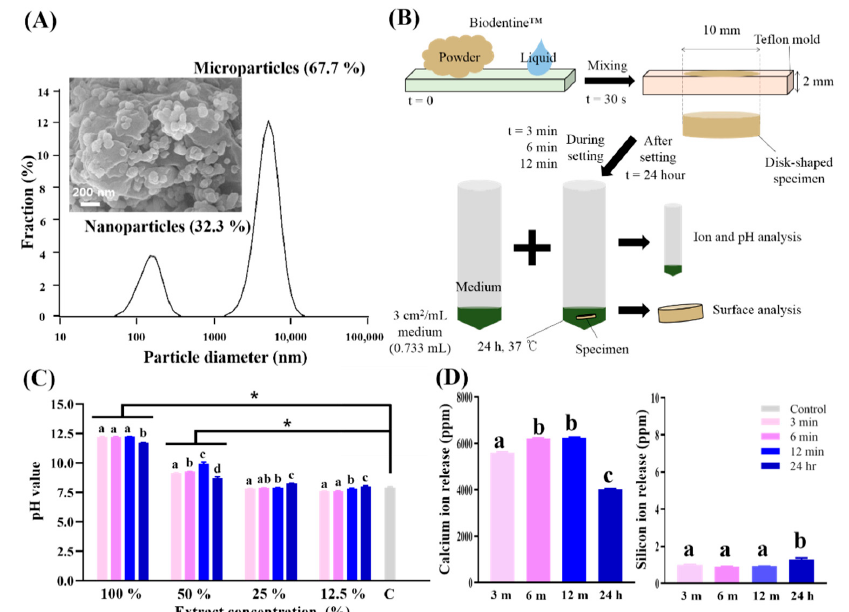
Figure 1. Schematic of this test procedure with di ff erent setting times for specimens and results of physicochemical analysis. ( A ) Particle size analysis of tricalcium silicate nanoparticle-containing cement (Biodentine ™ ) powder confirmed that the powder was composed of nanoparticles and microparticles. Scanning electron micrograph ( × 50,000) of the Biodentine ™ powder exhibited inhomogeneous microstructured surfaces with nanoparticles (approximately 100 nm). ( B ) The methodology used in the present study. To evaluate the biological e ff ect of Biodentine ™ , the specimens were collected after 3, 6 and 12 min and 24 h from starting setting in the mold, immersed in medium and kept at 37 ◦ C, 5% CO 2 and 100% humidity. After 24 h, the extracts were collected and kept in 4 ◦ C for use. ( C ) pH values of extracts with di ff erent dilution ratios. The asterisk indicates a significant di ff erence between the control and experimental groups ( p < 0.05). Biodentine ™ increased the pH of medium to be highly alkaline, and the after setting group exhibited a lower pH value than during setting groups in the 100% and 50% extracts. ( D ) Ions released from the extracts as detected by inductively coupled plasma-atomic emission spectrometry. The concentrations of Ca and Si ions released in all of the extracts are shown, while Mg, Cu, Zn and P ions were not detected in any extracts. The numbers of Ca ions released increased during the setting and decreased after setting. The numbers of Si ions were negligible in the therapeutic range. Detected values ( ± SD) are analytically presented in tabular form underneath each bar. ( C , D ) Di ff erent letters indicate significant di ff erences between groups ( n = 3, p <